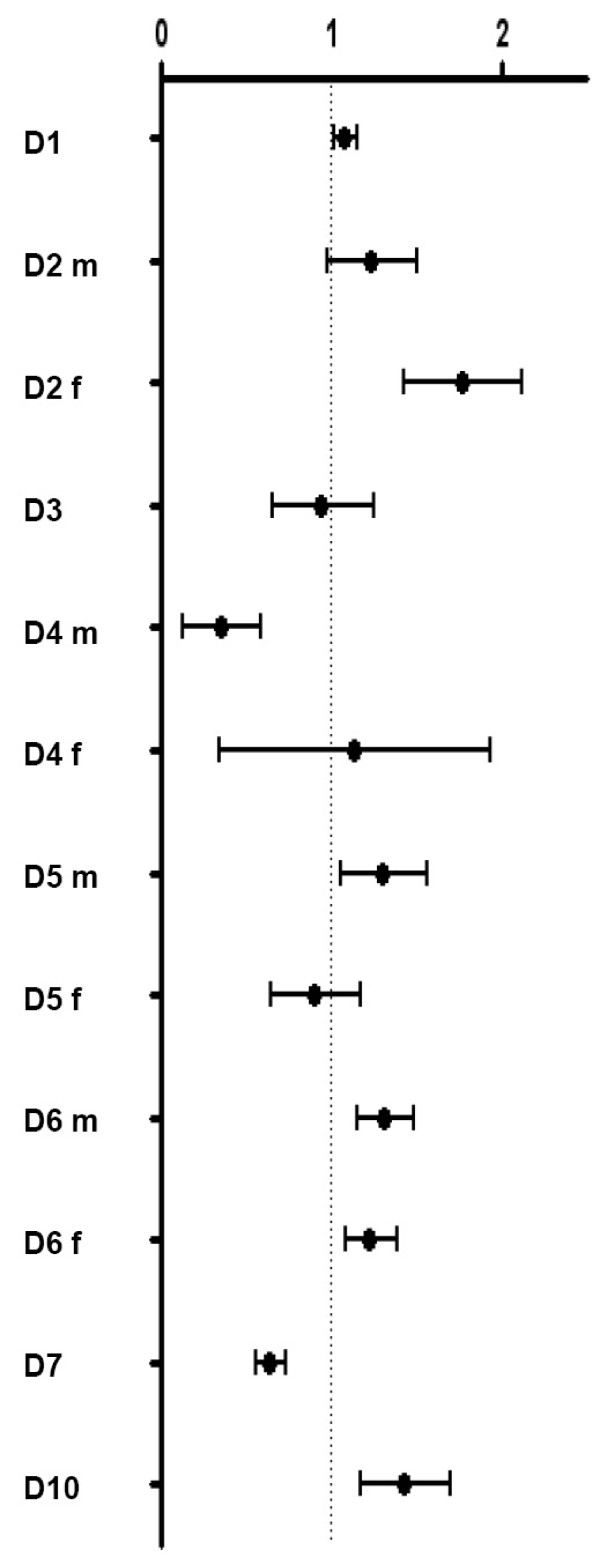
Impact of low SES influencing the incidence of type 2 diabetes. Effect sizes given as OR, HR or RR (central point) flanked by lower and upper 95% CI (results of high SES have been inverted, x-axis ends with 8, end points of higher results are not shown). Results of D8 and D9 are given as β-coefficients and are not included in Figure 2. D8 shows no effect of low SES; in D9 a considerably higher risk for type 2 diabetes incidence in the low SES group can be concluded.